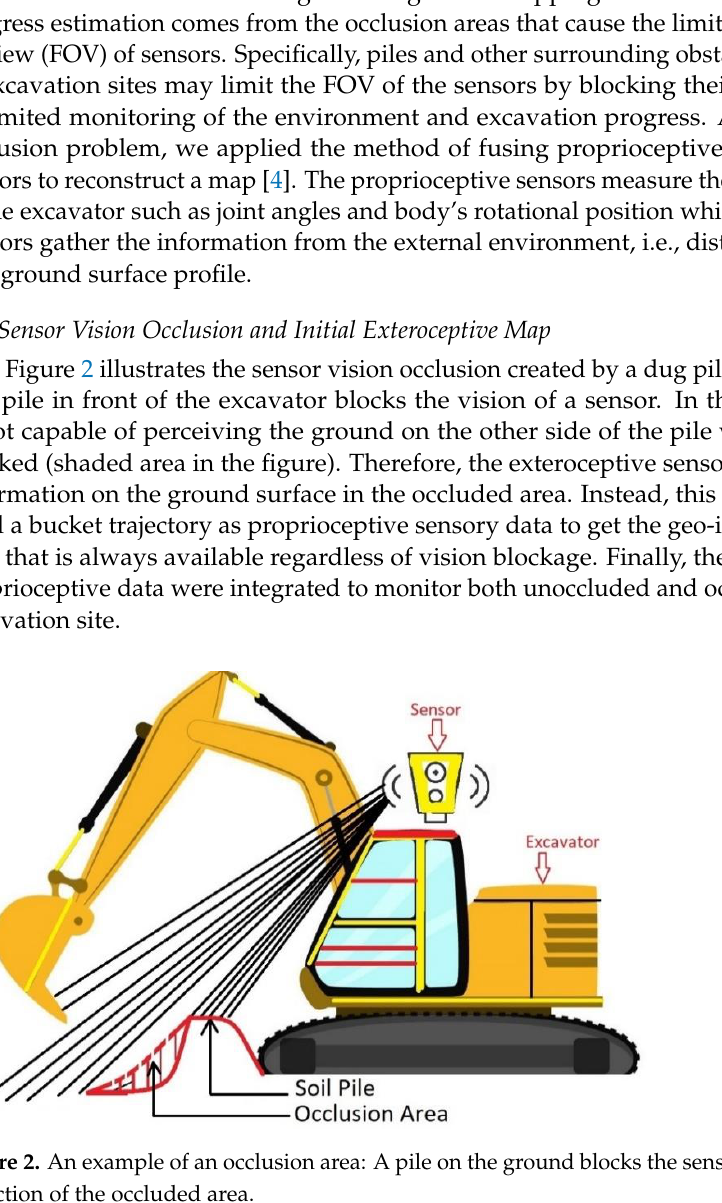
(b) Figure 3. Example of an occluded region on the excavation site: ( a ) Indication of a pile that blocks the sensor vision causing occlusion; ( b ) Initial exteroceptive map using LiDAR sensory data (point cloud) for the same site that includes the identical occlusion region.